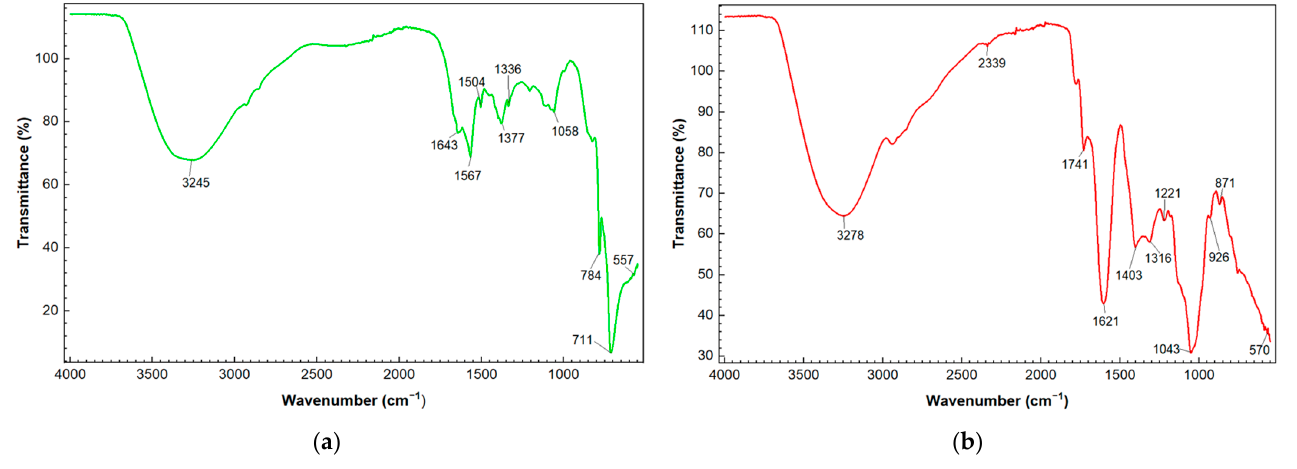
Figure 2. FTIR spectroscopy analysis. ( a ) FTIR spectrum of SeNPs-AGL synthesized with A. glaucum leaf extract. ( b ) FTIR spectrum of SeNPs-COF synthesized with C. officinalis flower extract.